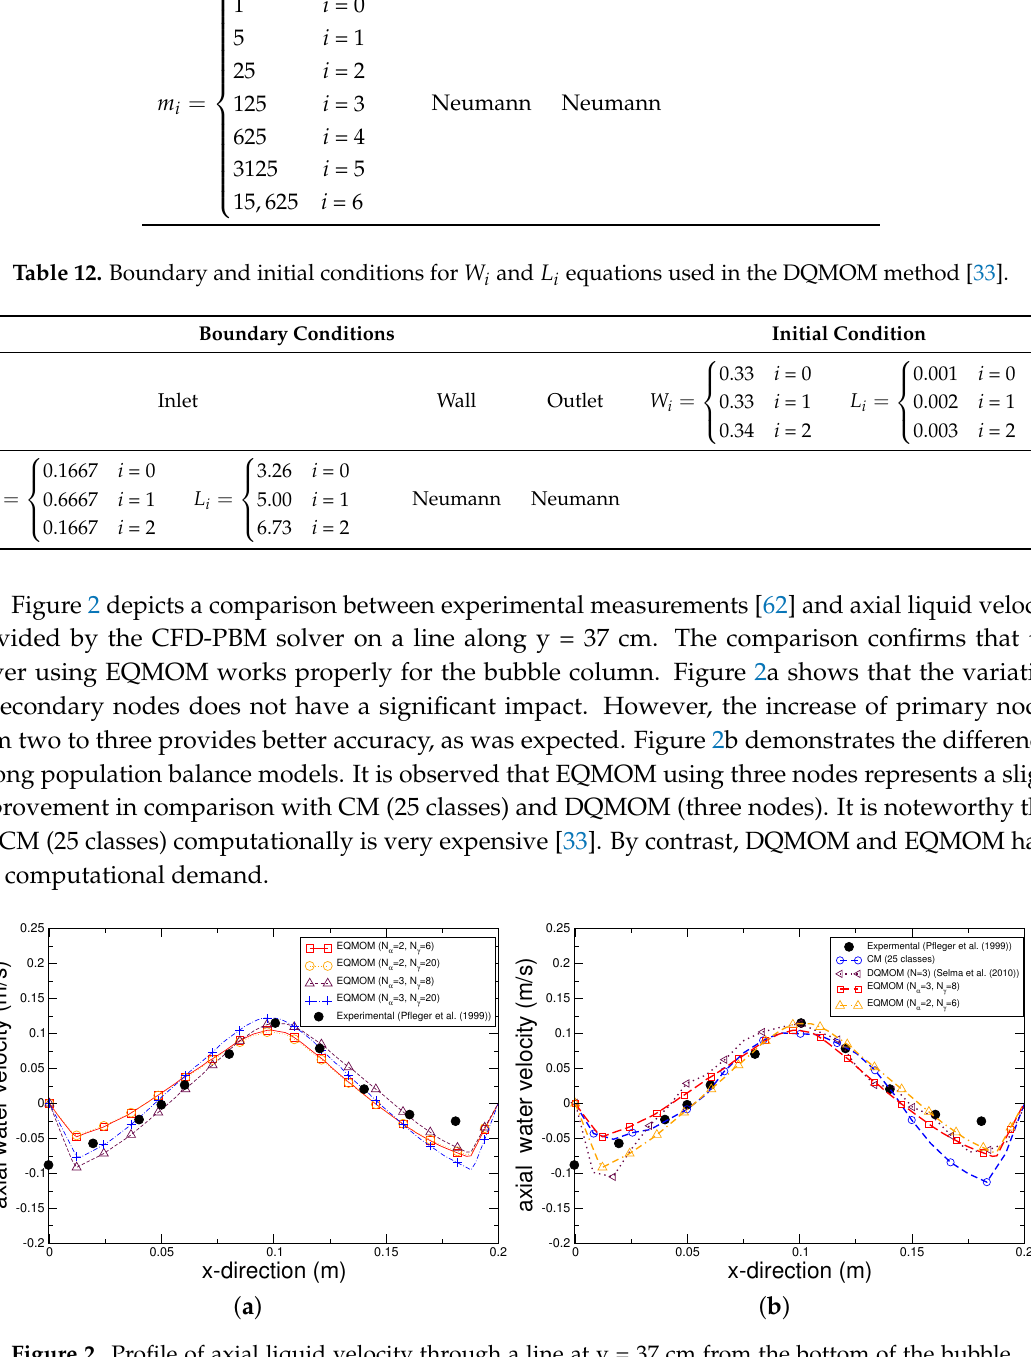
Figure 2. Profile of axial liquid velocity through a line at y = 37 cm from the bottom of the bubble column. ( a ) The variation of primary and secondary nodes and their effects on the predicted velocity profile. ( b ) The comparison among CM (classes), DQMOM (3 nodes), EQMOM (3 nodes) and EQMOM (2